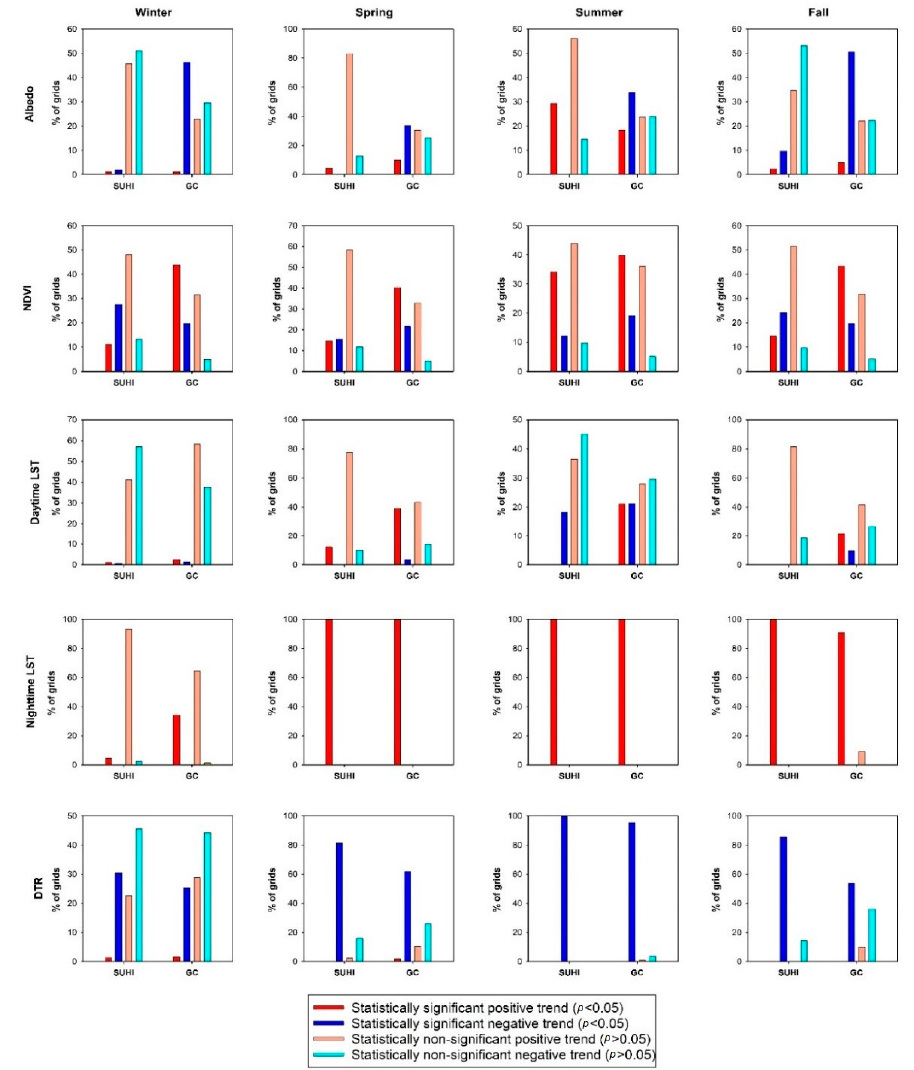
Figure 10. Statistical significance of trends of albedo, NDVI, daytime LST, nighttime LST and DTR from 2003 to 2019. Statistical significance was assessed using the modified Mann–Kendall statistic at the 95% confidence interval ( p < 0.05). Statistical significance of trends is presented for hotspot (SUHI) area, as compared to other parts of Greater Cairo (GC).